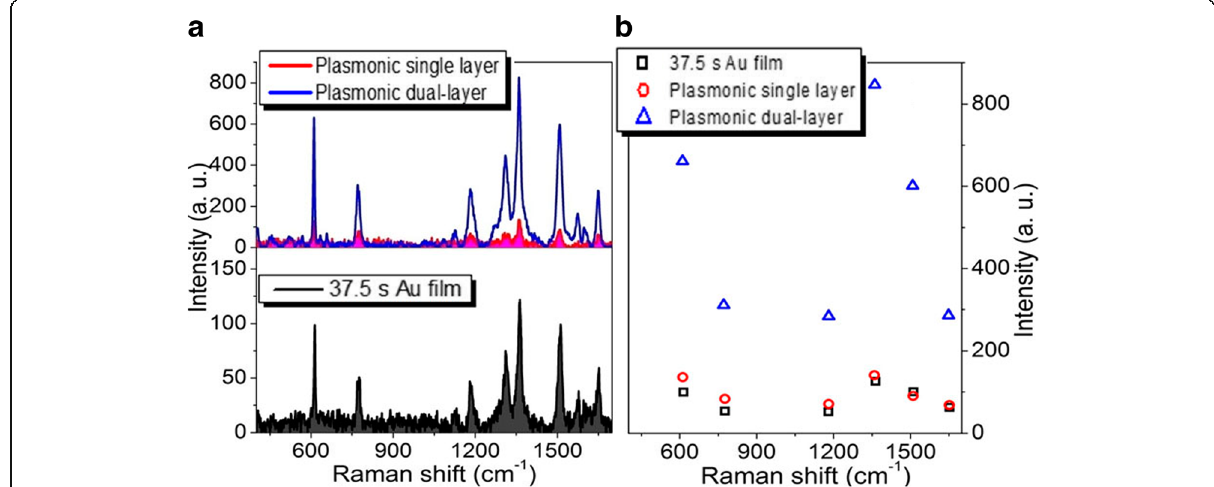
Fig. 5 a Raman spectra of the single-layer and dual-layer porous Au film structures and ultrathin Au film. b Intensity changes of several typical Raman peaks observed in the three Raman curves in a . The sputtering time for each layer of porous Au films and film is 37.5 s